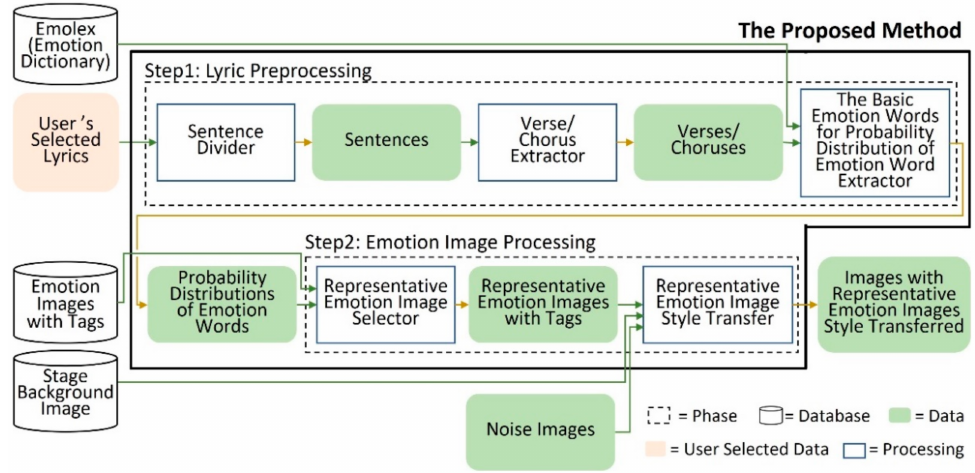
Figure 1. Process of applying emotions of song lyrics to stage background images.